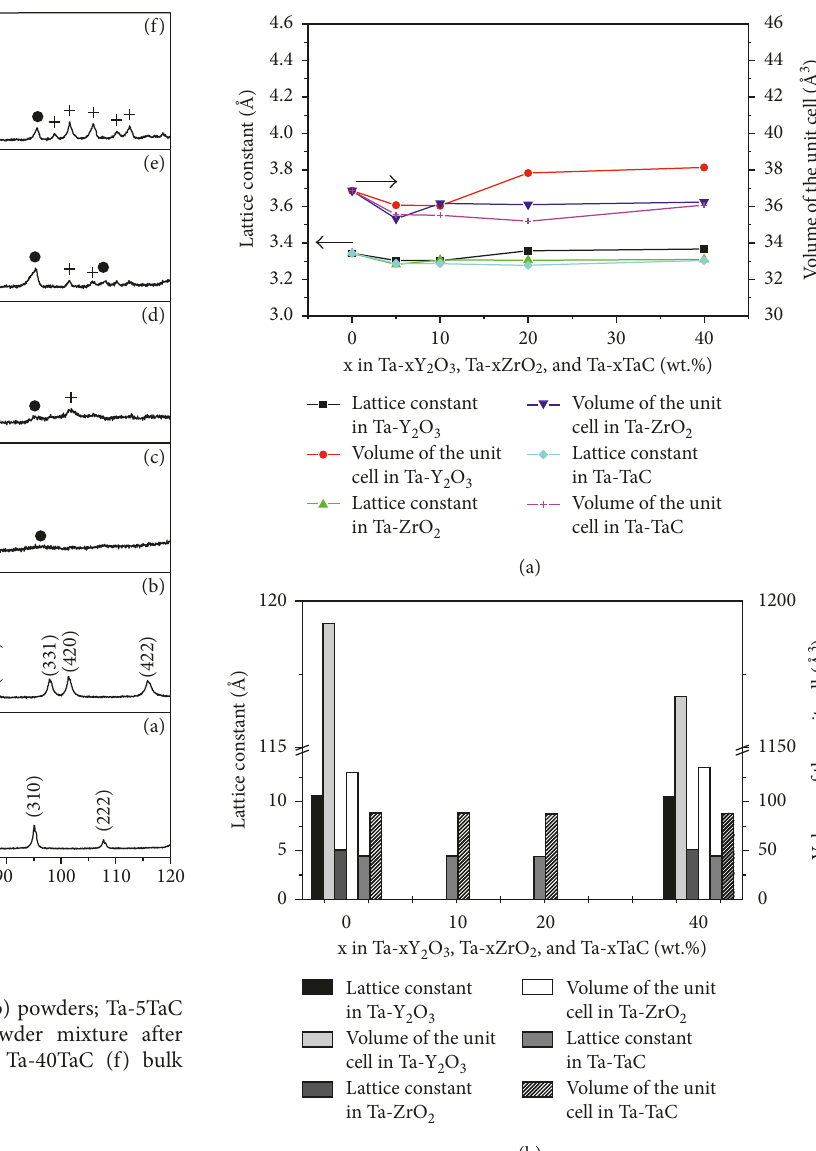
Figure 4: The effect of the Y 2 O 3 , ZrO 2 , and TaC content in the Ta-xY 2 O 3 , Ta-xZrO 2 , and Ta-xTaC composites on the Ta lattice constant and the Ta volume of the unit cell (after MA process) (a) and the effect of the Ta content in the Ta-xY 2 O 3 , Ta-xZrO 2 , and Ta-xTaC composites on the Y 2 O 3 , ZrO 2 , and TaC lattice constant and the volume of the unit cell (b); x � 0, 5, 10, 20, and 40 wt.%.